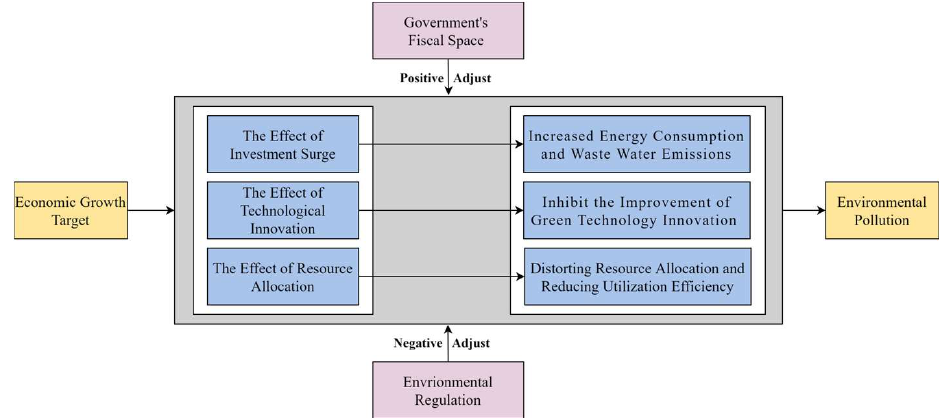
Figure 3. The channels and moderating mechanism of EGT aggravating EP.